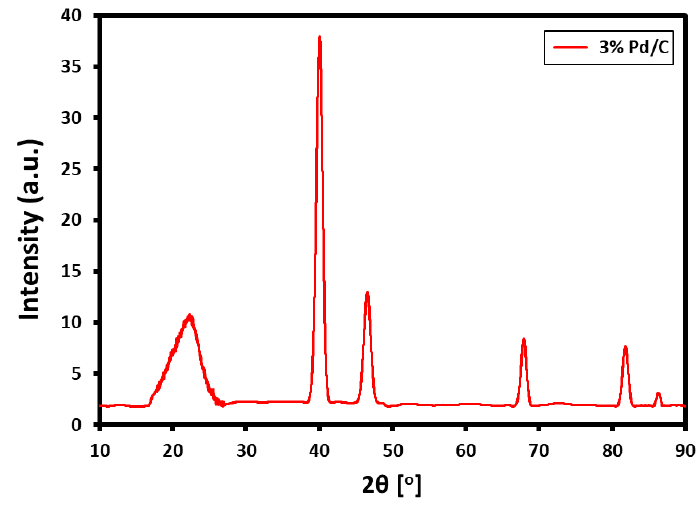
Figure 1. XRD analysis of 3% Pd/C.